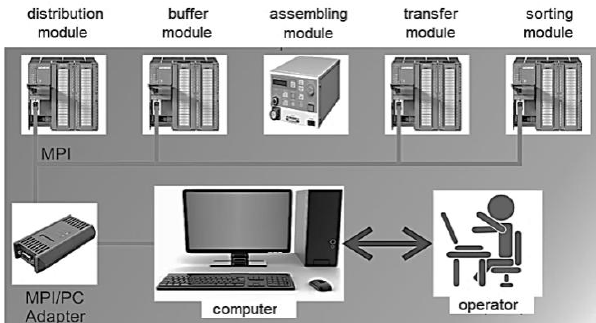
Figure 9. The structure of the modernized control system of the technological line